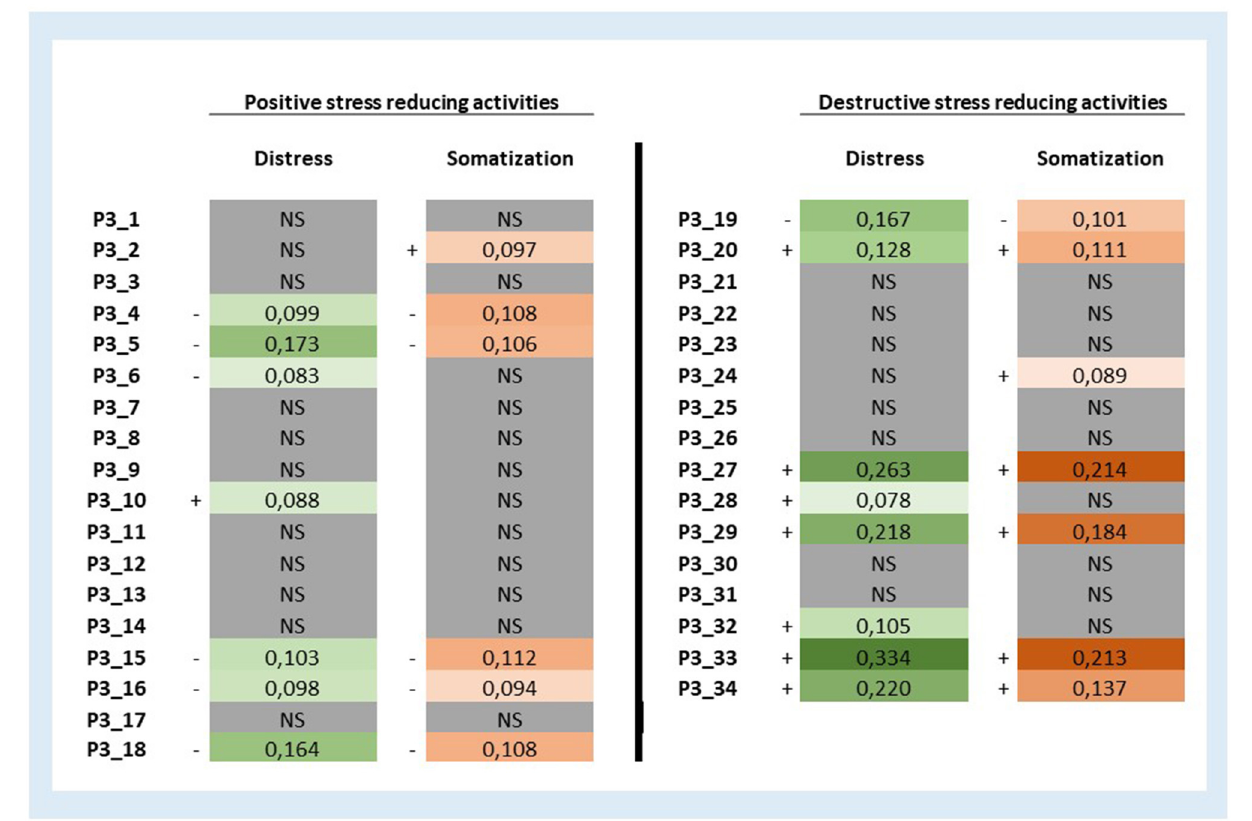
FIGURE 3 | Beta coefficients of 68 multiple linear regression models investigating the relation of each positive and destructive stress-reducing activity score during the last month on distress and somatization scores. Beta correlation coefficients from 68 multiple linear regression models (34 with distress as a dependent variable and 34 with somatization as a dependent variable). Models with distress as the dependent variable were controlled for sex, married, providing covid-19 care, education: undergraduate level. Models with somatization as the dependent variable were controlled for sex, married, providing covid-19 care, education: undergraduate level, place of work: residential care. The somatization score was transformed using a natural log-transformation because of heteroscedasticity. The maximum p -values designated as “significant” by Holm’s Sequential Bonferroni Procedure in distress and somatization models were 0.002024 and 0.000991, respectively. NS, not